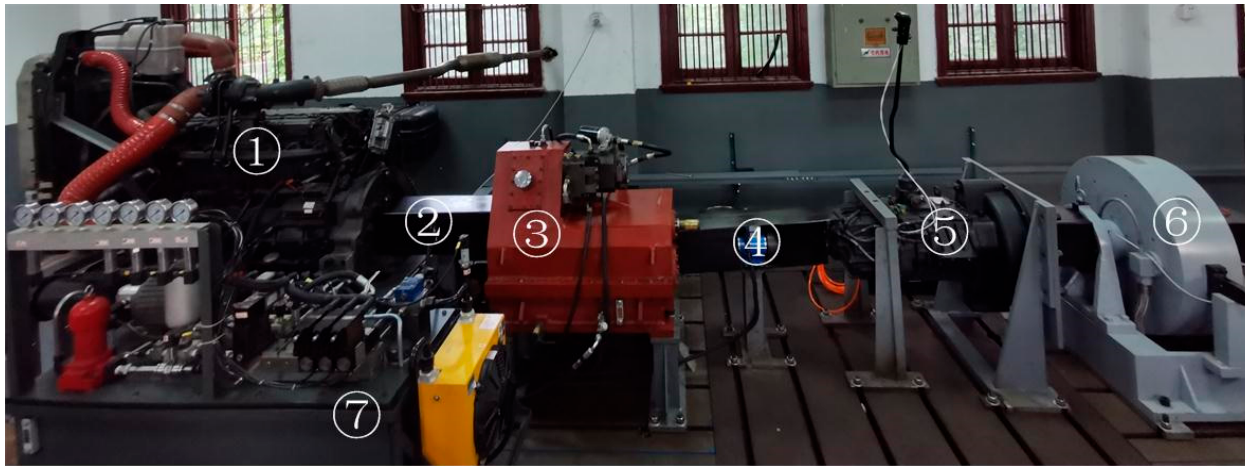
Figure 3. Test bench of HST variable speed control of the tractor. ① Engine (DEUTZ TCD2013L062V); ② speed and torque sensor of ZJ-2000A model; ③ HST; ④ speed torque sensor of the ZJ-5000A model; ⑤ pinion box; ⑥ electrical eddy current dynamometer of the DW250 model; ⑦ hydraulic system (realizing lubrication, cooling and other functions).